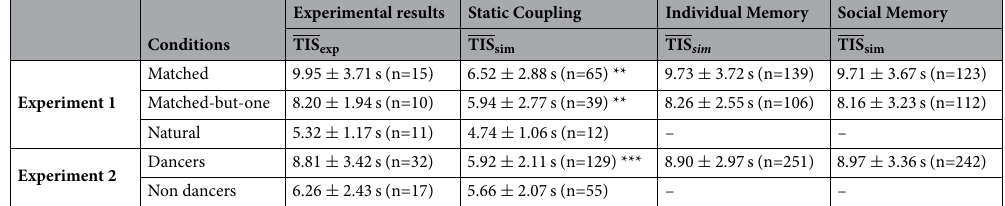
Table 1. Comparison of the Static Coupling, Individual Memory and Social Memory models with the experimental results: average (with standard deviation) experimental Time-In-Sync TIS exp versus average (with standard deviation) simulated Time-In-Sync TIS sim ; ** p < 0.01 , *** p < 0.001 . See Supplementary Information for statistical